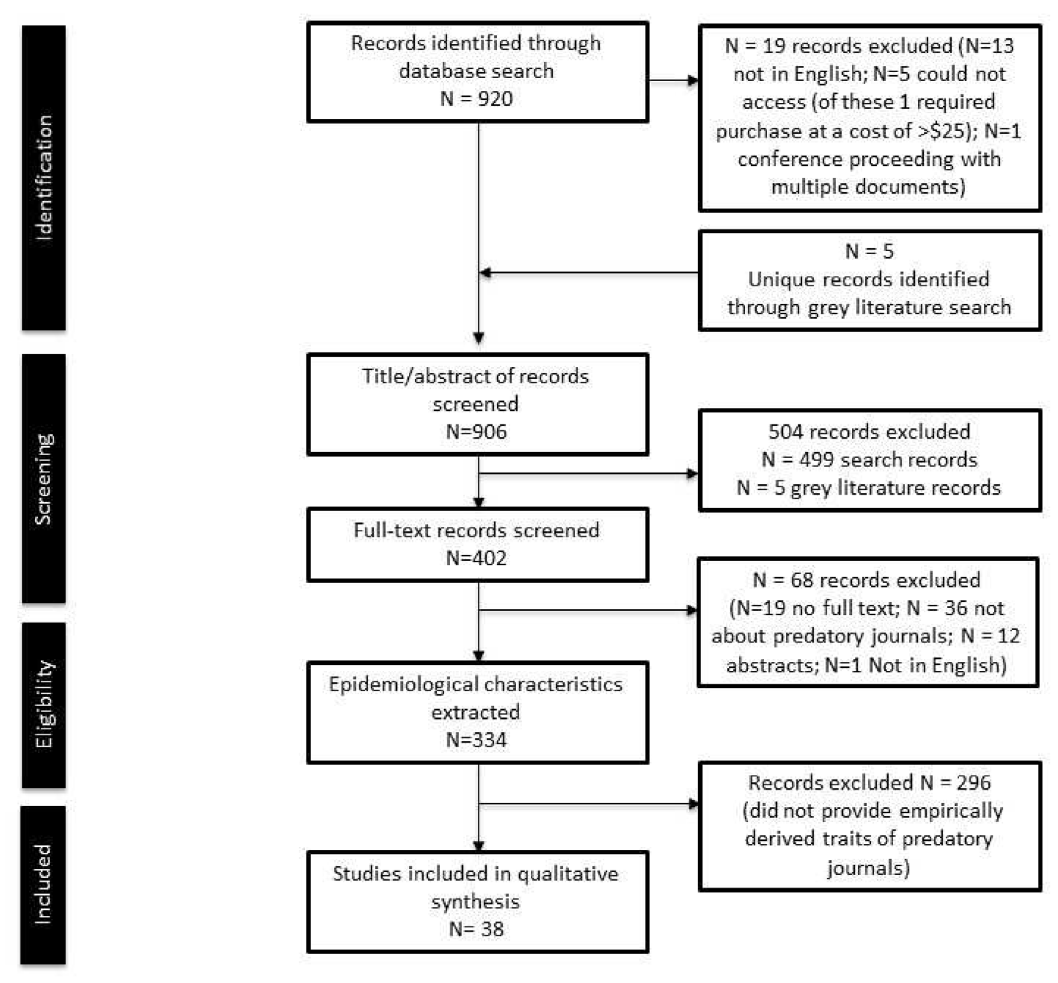
Figure 1. Preferred Reporting Items for Systematic reviews and Meta-Analyses (PRISMA) flow diagram summarizing study